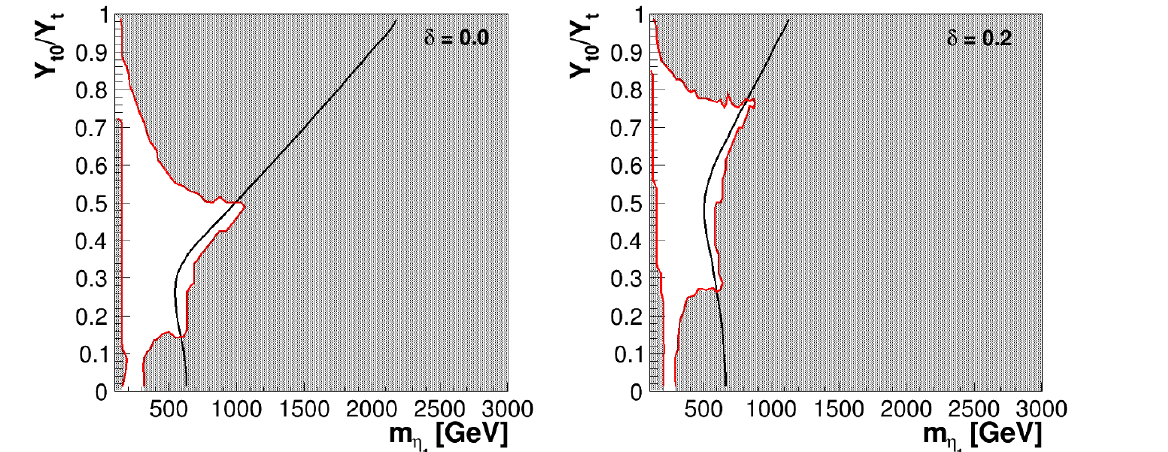
Figure 10 . Combination of constraints from the relic density measurement and direct detection experiments. The region to the right of the black line is excluded by overclosure of the Universe, while the region within the red line is still allowed by the direct